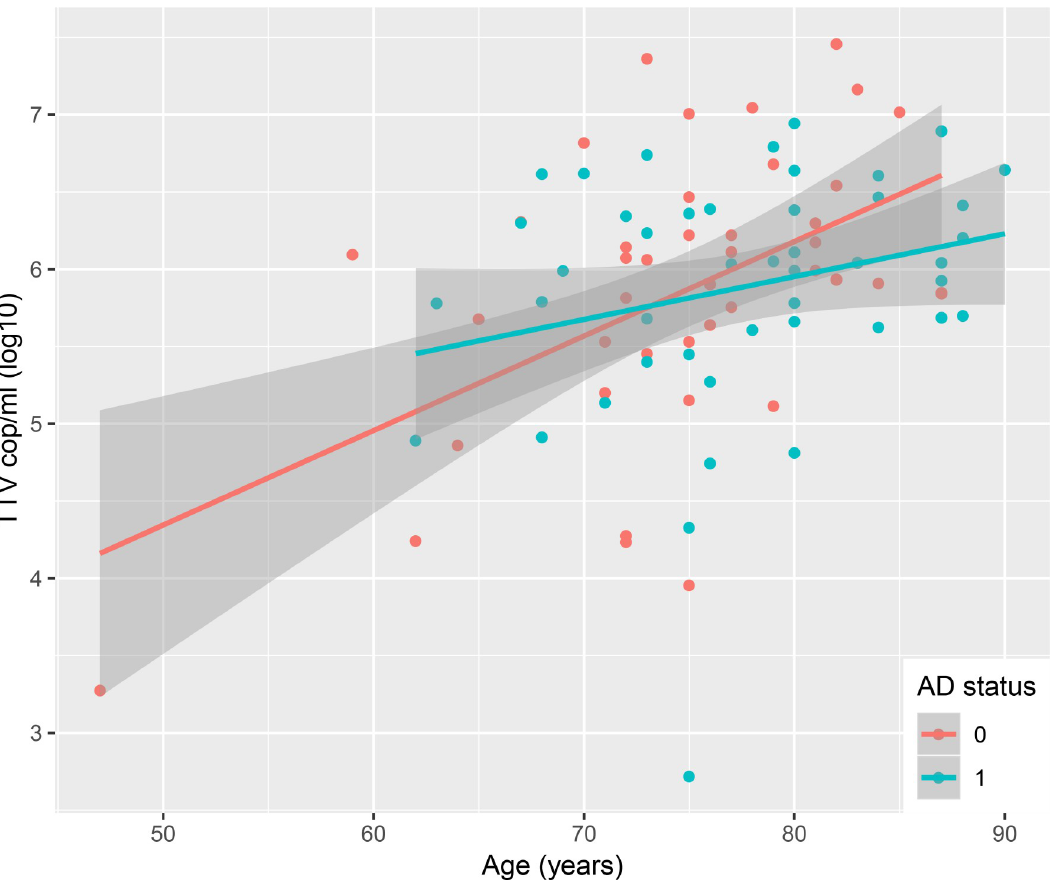
Fig 2. TTV viral load vs. age. TTV viral load increases with age. Alzheimer status coded in blue (AD) and red